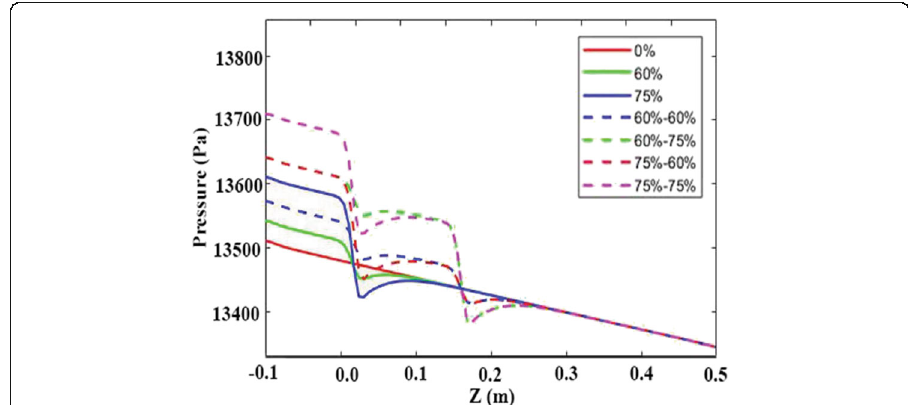
Fig. 6 Variation of pressure in the normal arter and arteries with single and double